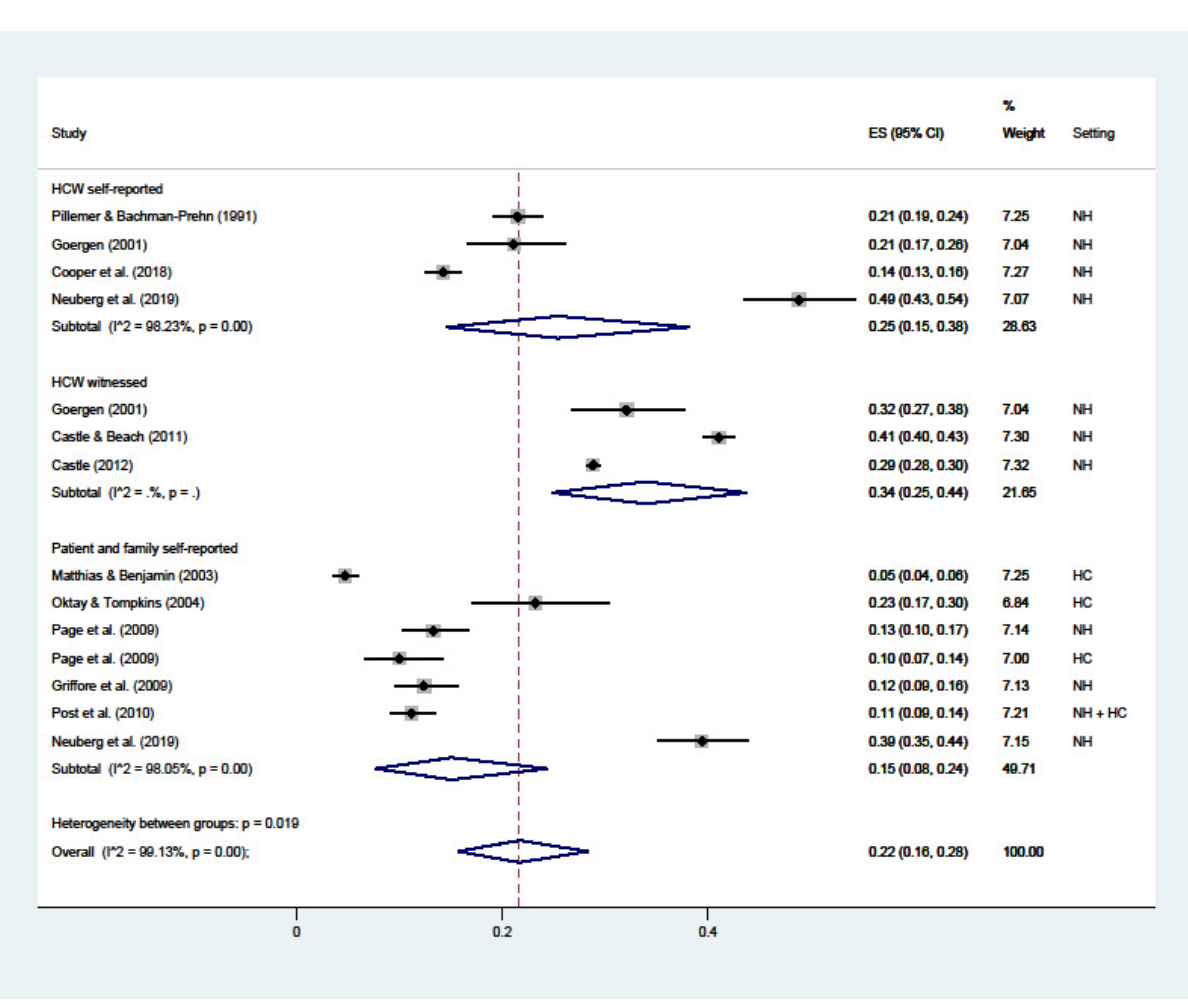
Figure 4. Forest plot of the prevalence of verbal abuse in LTC. Subgroup meta-analyses by (Healthcare workers (HCW) self-reported, HCW witnessed, or patient and family self-reported). NH: nursing home; HC: home care.